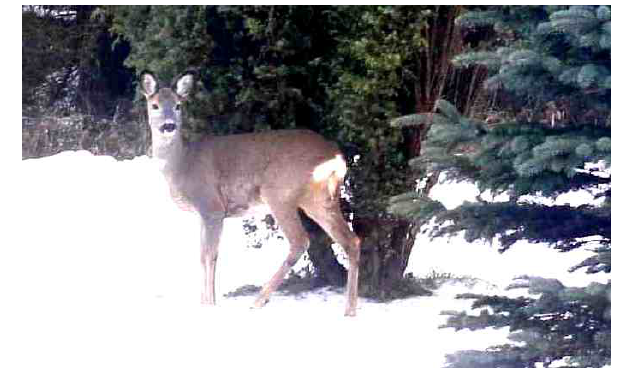
Figure 26. A black coloured adder (Hell Adder). This species lives in the compound, deterring the vacationers from intruding.